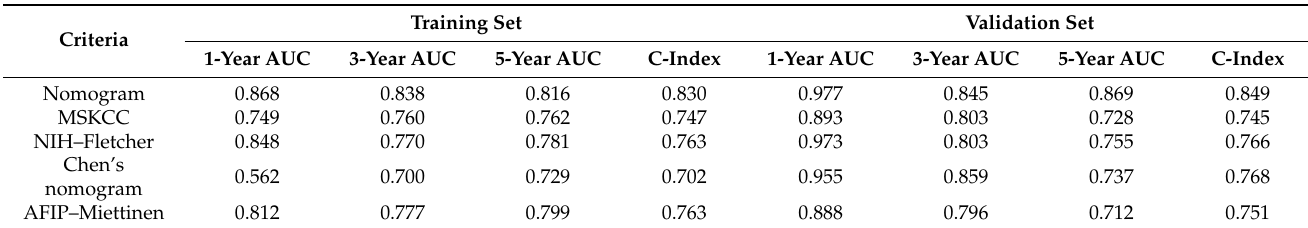
Criteria Table 3. The 1-, 3-, and 5-year AUC and C-index according to different criteria.